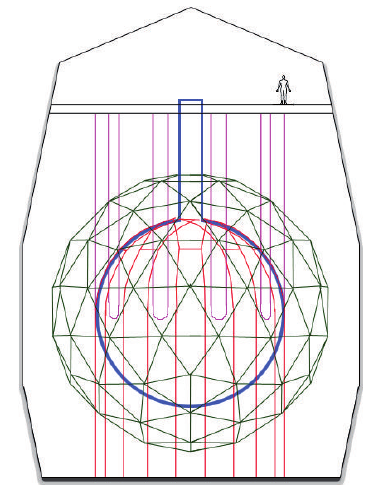
Figure 1: The SNO+ detector, figure from [9]. The 12m diameter acrylic vessel (blue) is viewed by ∼ 9300 PMTs supported by a ∼ 18m diameter geodesic structure (green) and is held by a system of high purity ropes (purple). The AV and the PSUP are within a volume of highly purified water. A rope net (red) will be used to offset the buoyancy of the liquid scintillator contained within the